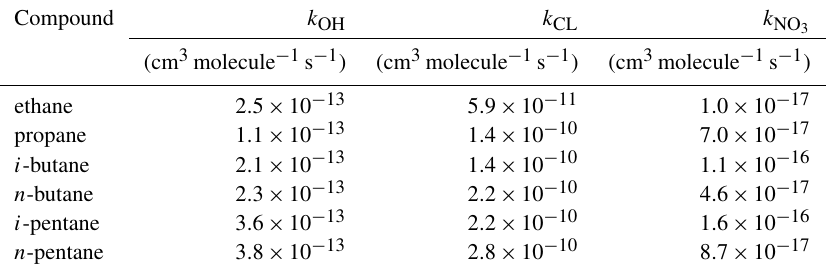
Table 5. Reaction rate constants of C 2 –C 5 alkanes.